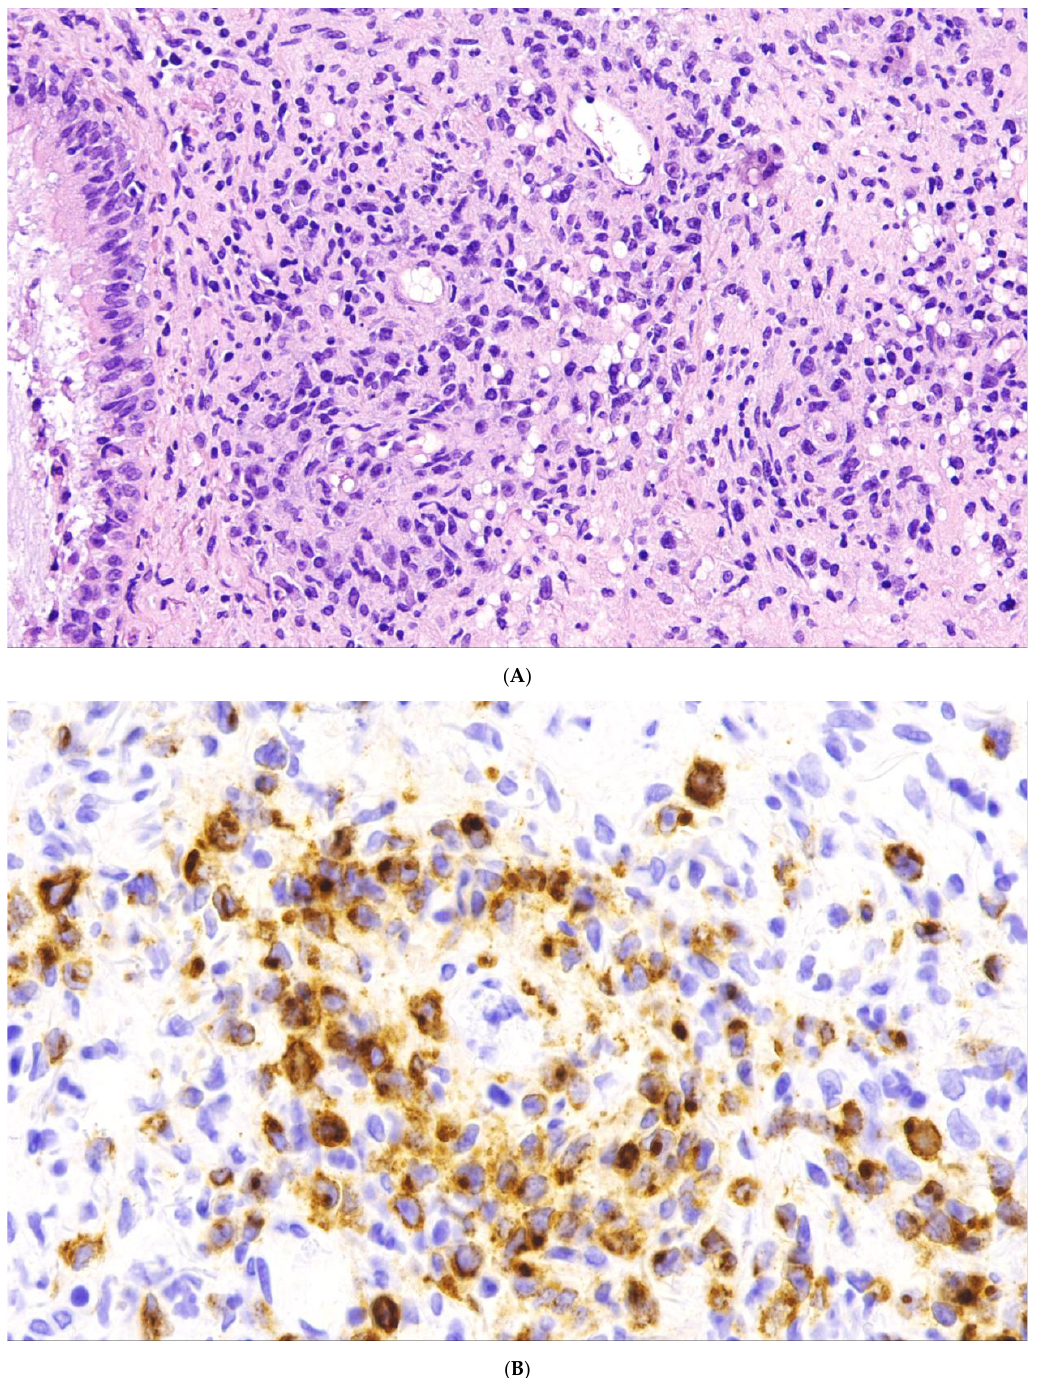
Figure 6. Lymphomatoid granulomatosis. ( A ) (H&E ×200). There is an angiocentric infiltration of several medium-sized blood vessels by a polymorphic lymphomatous infiltrate. ( B ) (×400) LMP staining confirms EBV association and highlights medium-sized to large blasts infected by EBV.